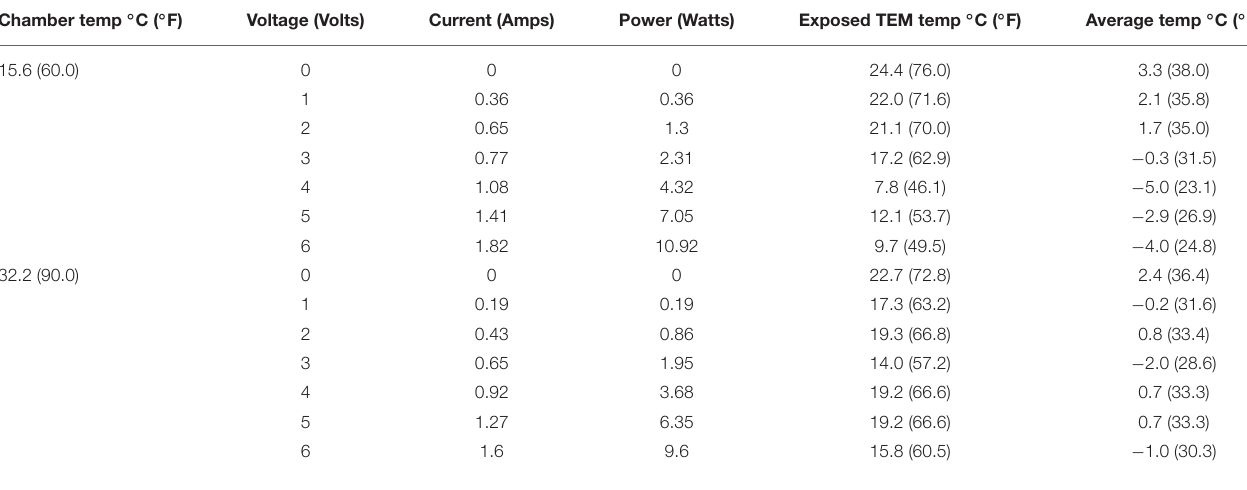
TABLE 2 | Results of thermal testing (cooling